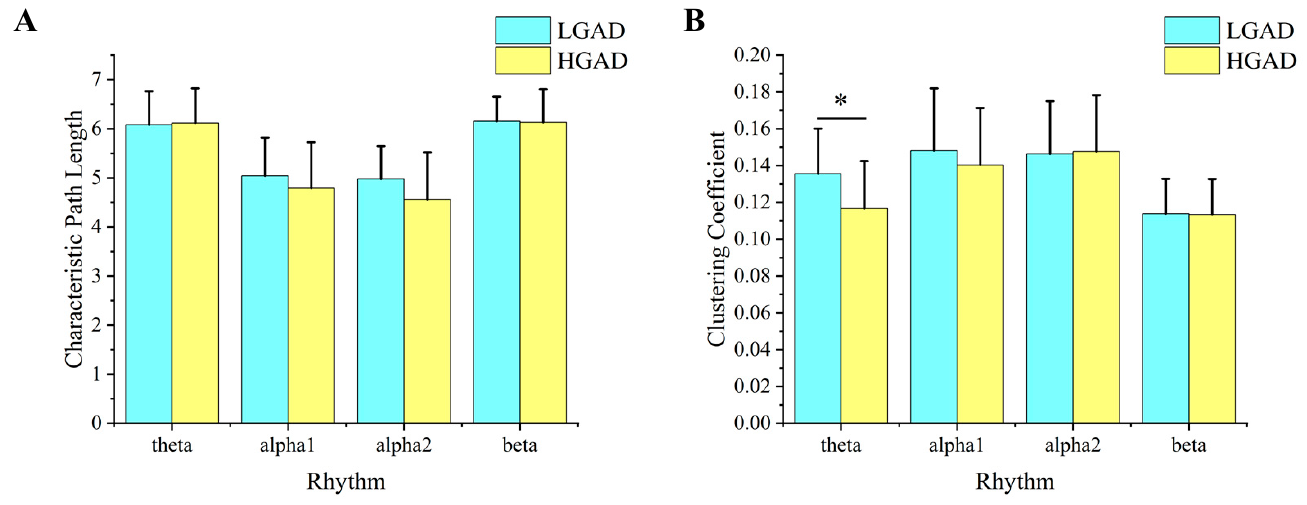
Figure 2. Brain function network topology of HGAD and LGAD in theta, alpha1, alpha2, beta rhythms. The red edge indicates that HGAD has a higher weight on the edge. The blue edge indicates that LGAD has a higher PLI value.